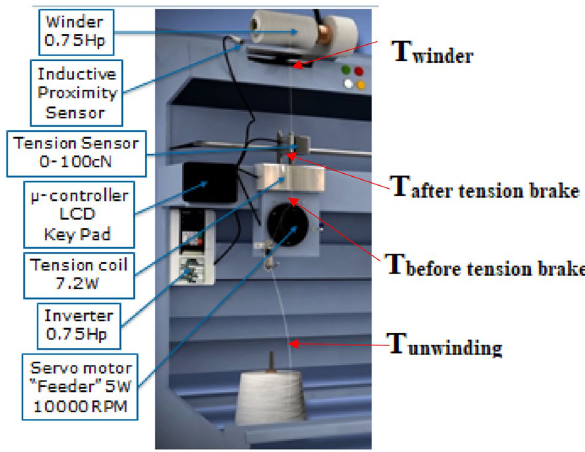
Figure 8. Mechanical model of the soft winding machine [Courtesy of EL Sharq El Awsat Co.].